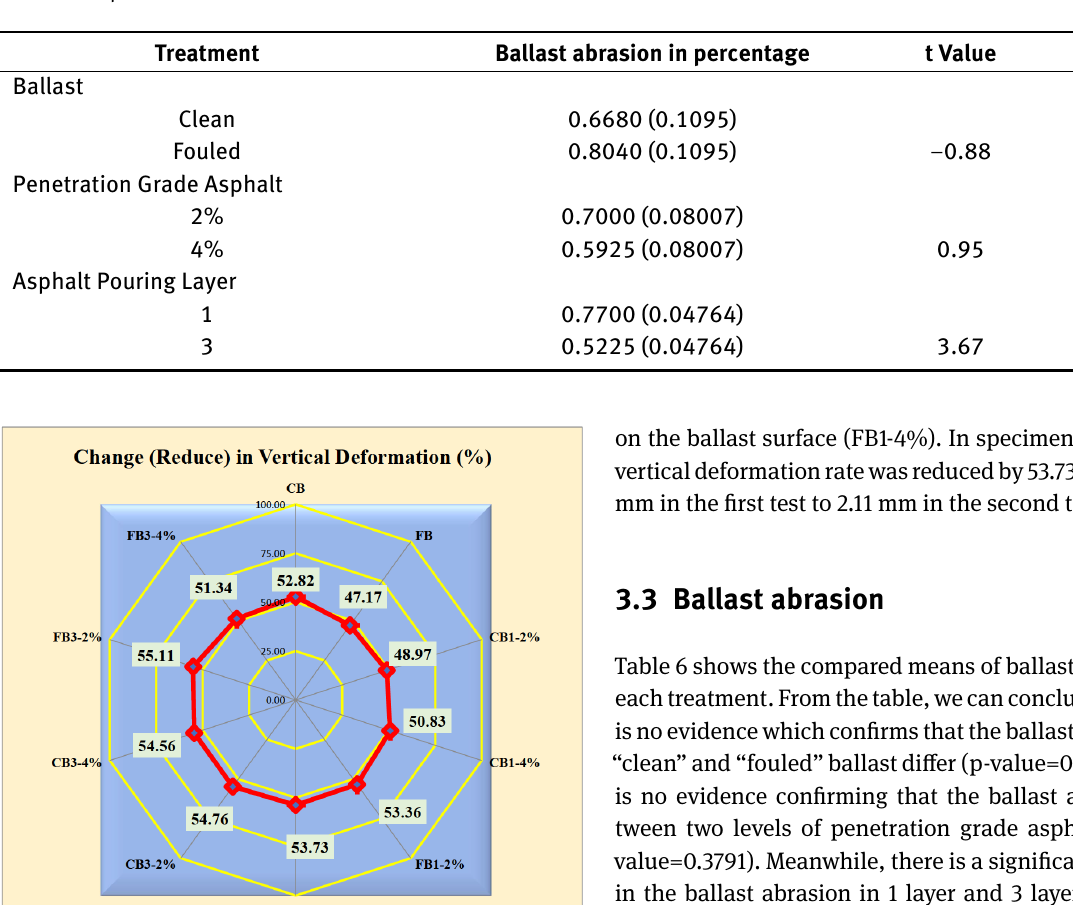
Table 6: Compared means of ballast abrasion